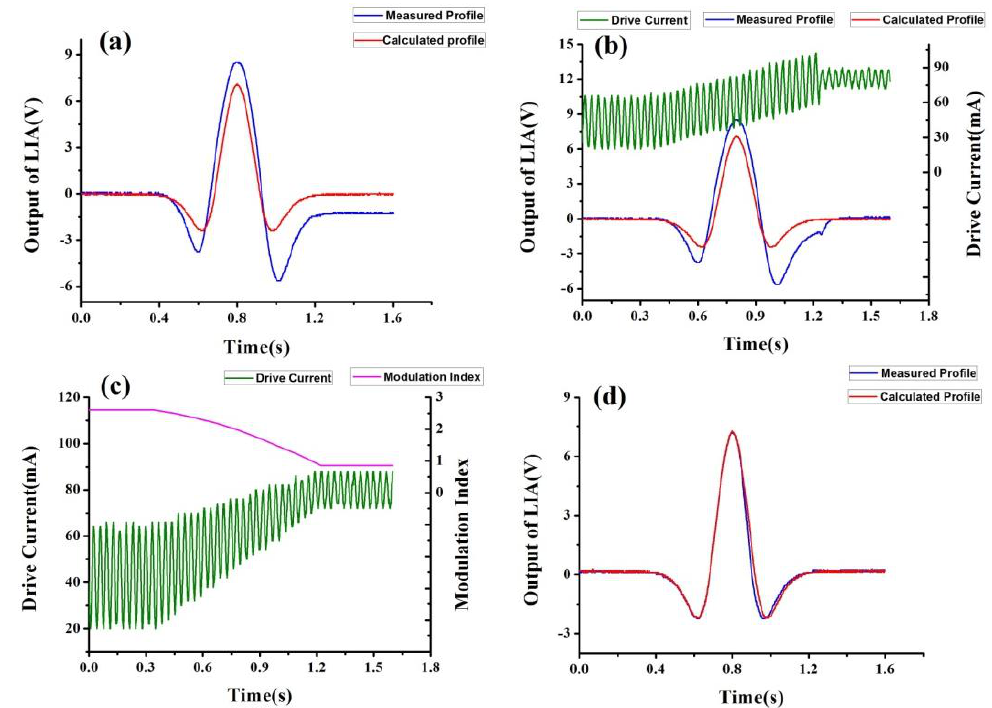
Figure 3. ( a ) shows the oscilloscope traces of the output of the lock-in amplifier (LIA) with amplitude modulation (blue line) and the signal sent out by digital-to-analog (DA) of our microcontroller (red line) respectively; ( b ) shows the oscilloscope traces of the output of the LIA (blue line), the signal sent out by DA (red line) and the drive current (green line); ( c ) shows the oscilloscope trace of the drive current (green line) and the rule of the modulation index over time (pink line); ( d ) shows the oscilloscope traces of the output of the LIA with modulation index adjustment (blue line) and the signal sent out by DA (red line) respectively.